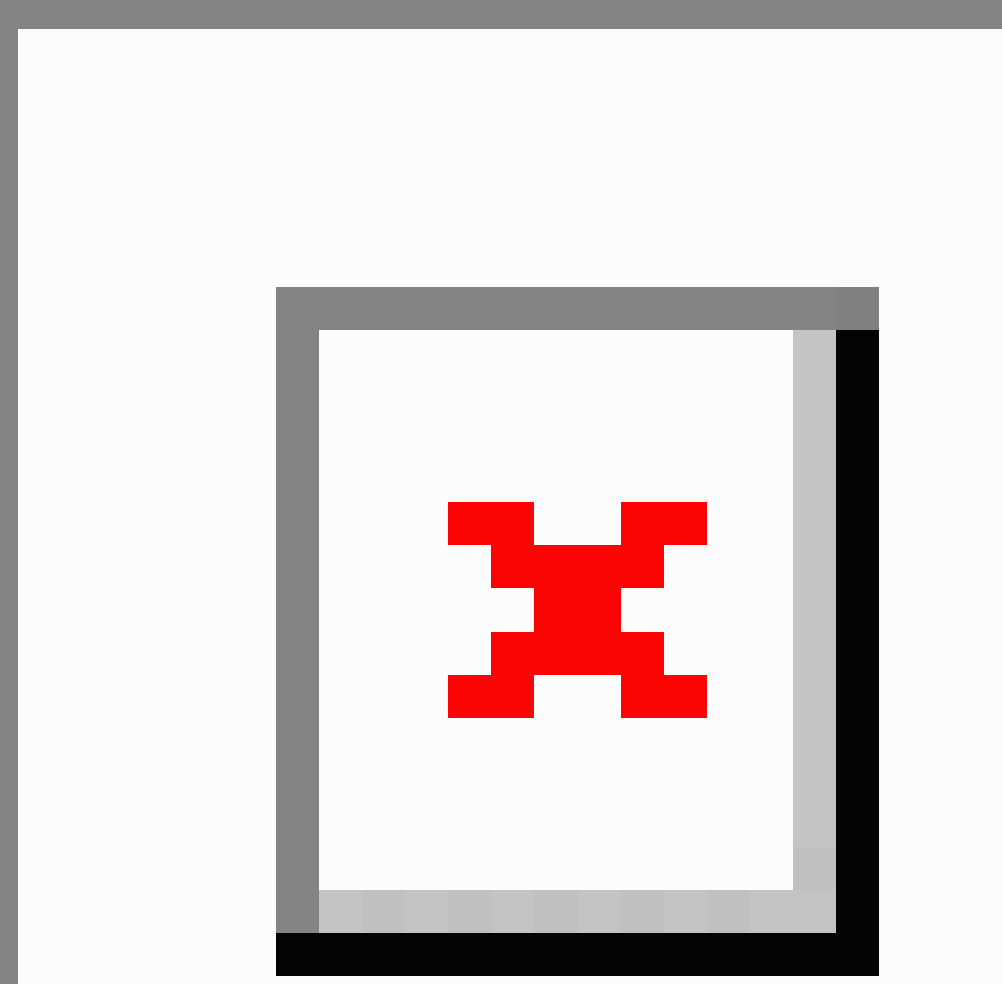
Figure 4. Screenshot of Progress webpage with Urge Tracker for participants who reported that they had quit using